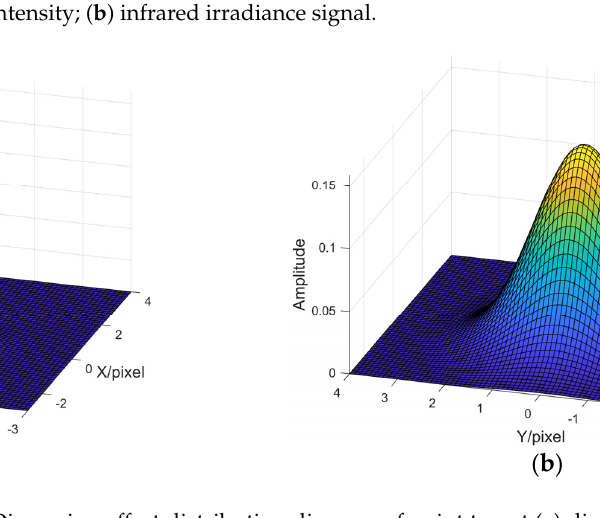
Figure 7. The noisy radiation intensity signal.